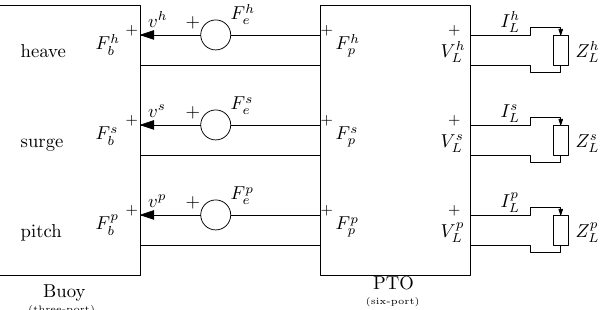
Fig. 2: Multi-Port representation on the